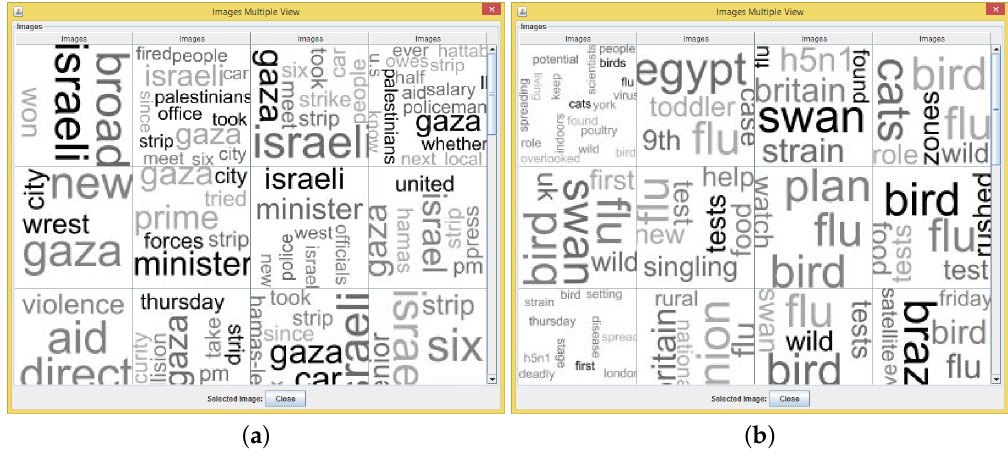
Figure 8. Analysis of the NEWS-13 dataset: ( a ) some tag clouds from Selection A from Figure 6 and ( b ) some tag clouds from Selection B from Figure